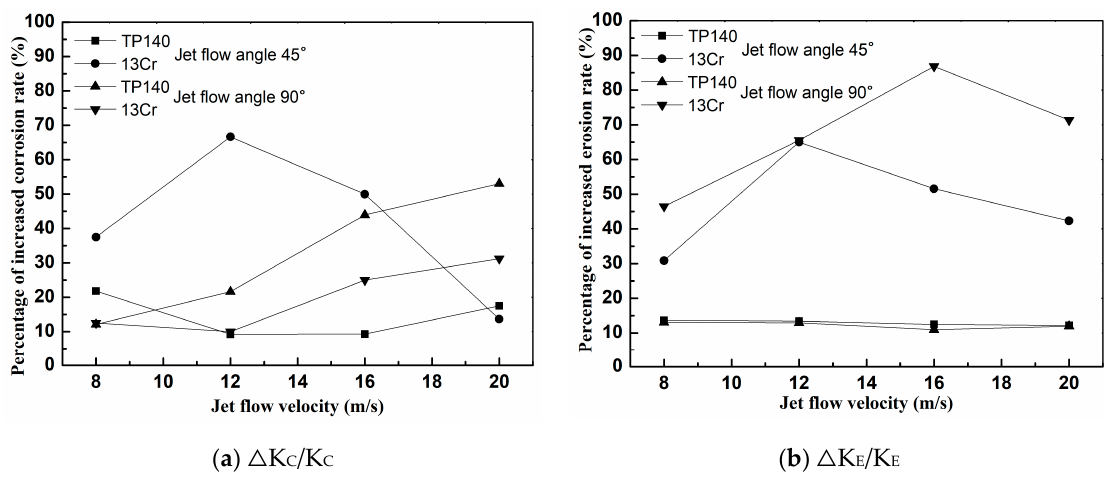
Figure 10. Increased erosion and corrosion rate under liquid–solid and gas–solid or liquid flow: ( a ) increased corrosion rate; ( b ) increased erosion rate.